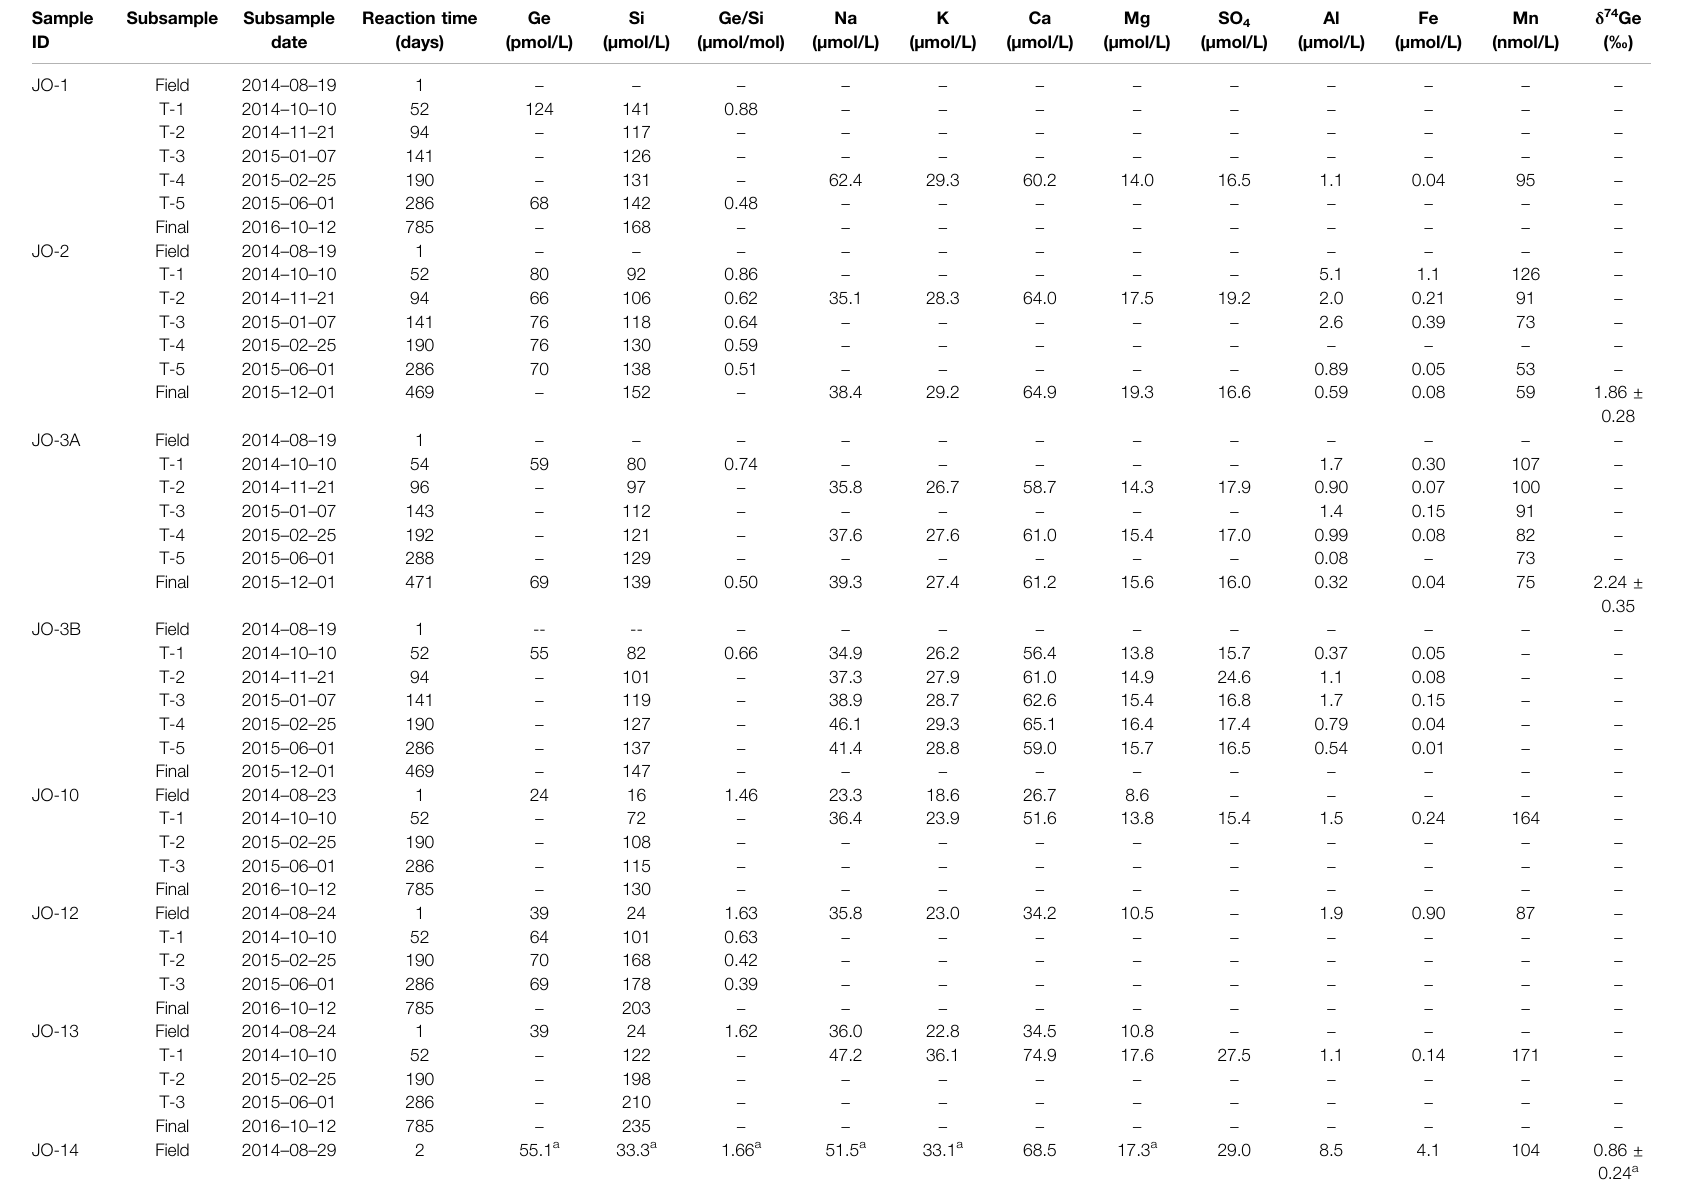
TABLE 2 | River sediment weathering experiment data: main rivers (Akuliarusiarsuup Kuua (AK), Qinnguata Kuussua (QK), and Watson